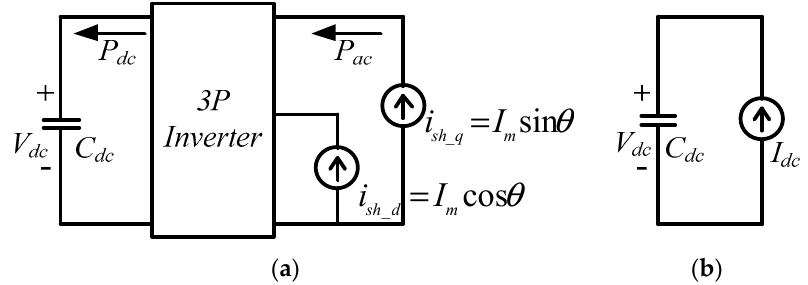
Figure 5. Equivalent circuits of the voltage control loop: ( a ) equivalent circuit under synchronous reference frame; ( b ) equivalent circuit on direct current (DC) side.